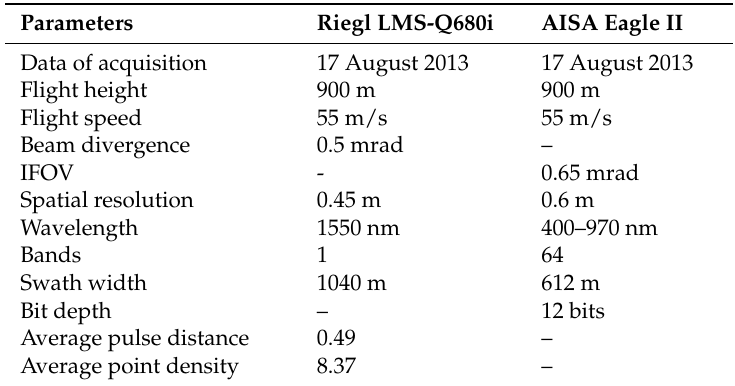
Table 2. The summary of flight parameters and properties of the full-waveform LiDAR and hyperspectral